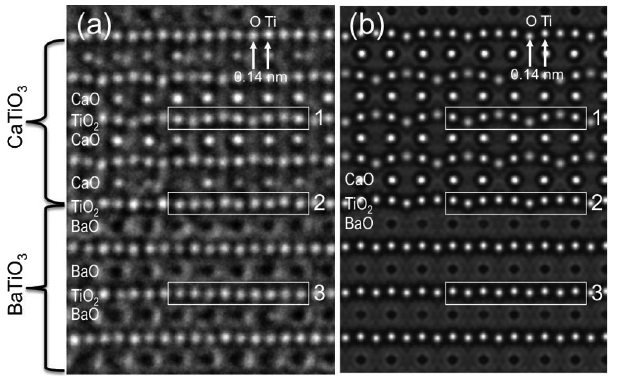
FIG. 1. Experimental and simulated HRTEM images showing oxygen octahedral tilts in the 4 BTO = 4 CTO superlattice film grown on a STO substrate along [110]. (a) Experimental HRTEM image using an amplitude contrast imaging method ( Cs ¼ 3 μ m, Cc ¼ 1 μ m, Δ f ¼ − 1 nm). BaO columns (dark dots) and CaO columns (bright dots) show different channeling contrast. Oxygen atomic columns displace differently, either upward or downward, with respect to the central Ti atoms in boxes 1, 2, and 3. Here, 0.14 nm indicates the spacing between Ti and O columns. The accumulated electron dose is 3 × 10 4 electrons = nm 2 . (b) Simulated HRTEM image using the atomic positions obtained from first-principles calculations. The simulated image matches well with the experimental image except for a sharper column contrast in the simulated image compared to the experimental one because electron-beam- induced object excitations are omitted, as pointed out by Kisielowski et al. (see Ref. [19])